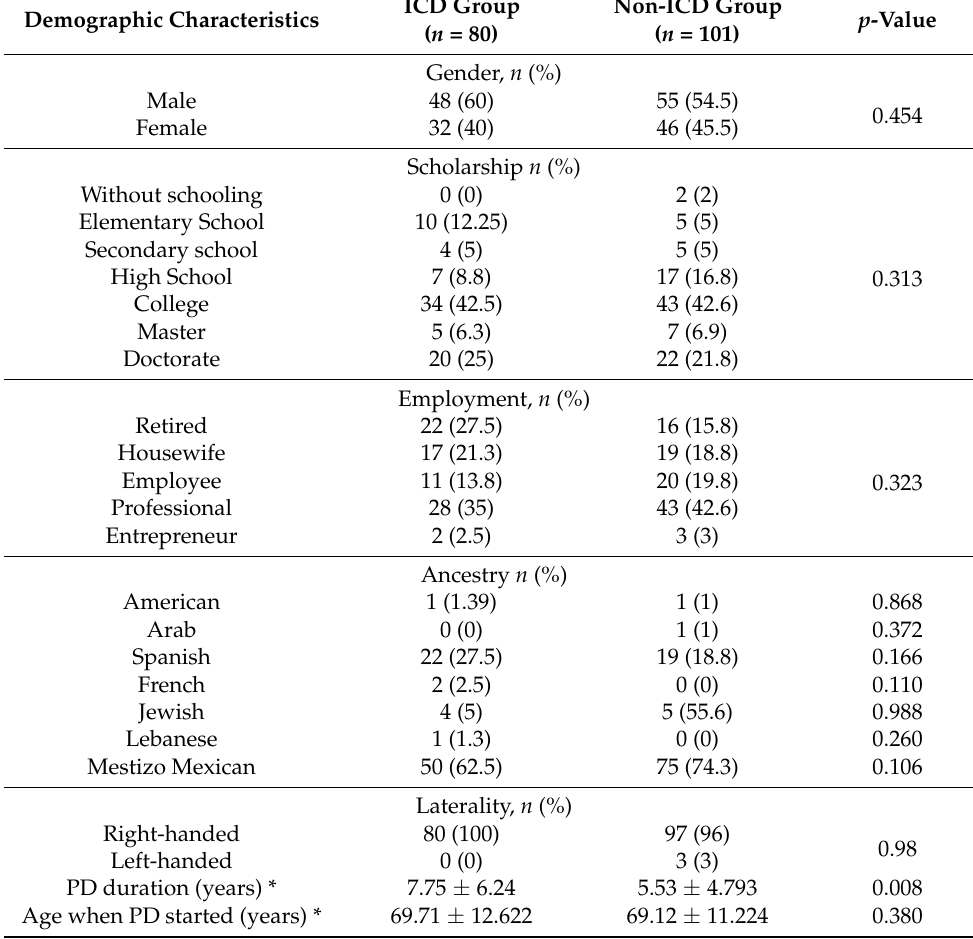
Table 1. Characteristic demography of patients in each